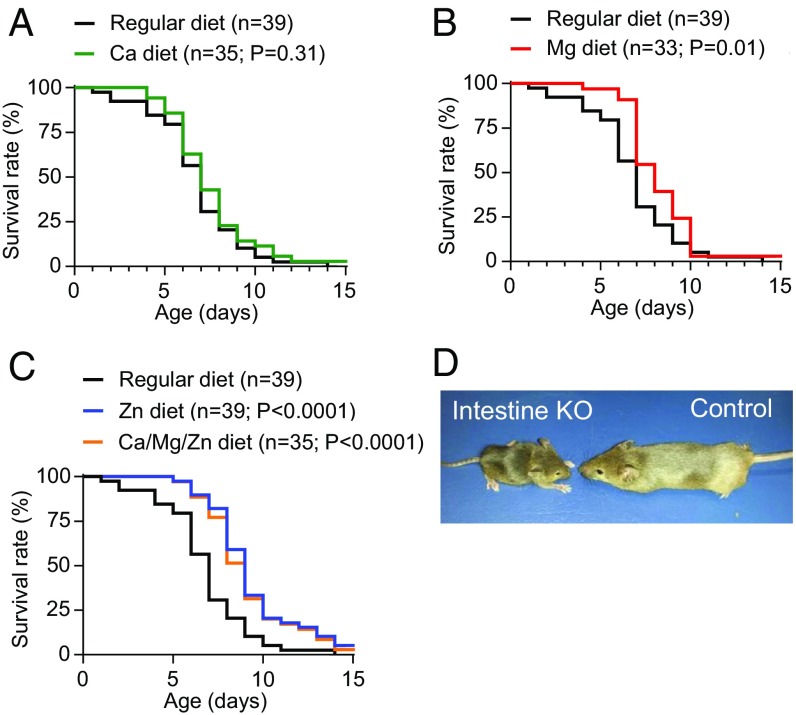
Effects of Ca2+, Mg2+, and Zn2+ dietary treatments on survival of mice with intestine-restricted inactivation of Trpm7. (A–C) Kaplan–Meier survival distributions of Trpm7fl/fl;Villin1-Cre mice maintained on a regular diet vs. Ca- (A), Mg- (B), and Zn-supplemented and combined Ca/Mg/Zn-supplemented mice (C) as outlined in SI Appendix, Table S2. The indicated P values were calculated by comparison of each supplemented group vs. the group maintained at regular diet using a log-rank test; n, number of mice examined. (D) Representative images of a surviving P33 Trpm7fl/fl;Villin1-Cre (intestine KO) mouse and a corresponding Trpm7fl/fl (control) littermate maintained at an enriched Zn2+ diet.